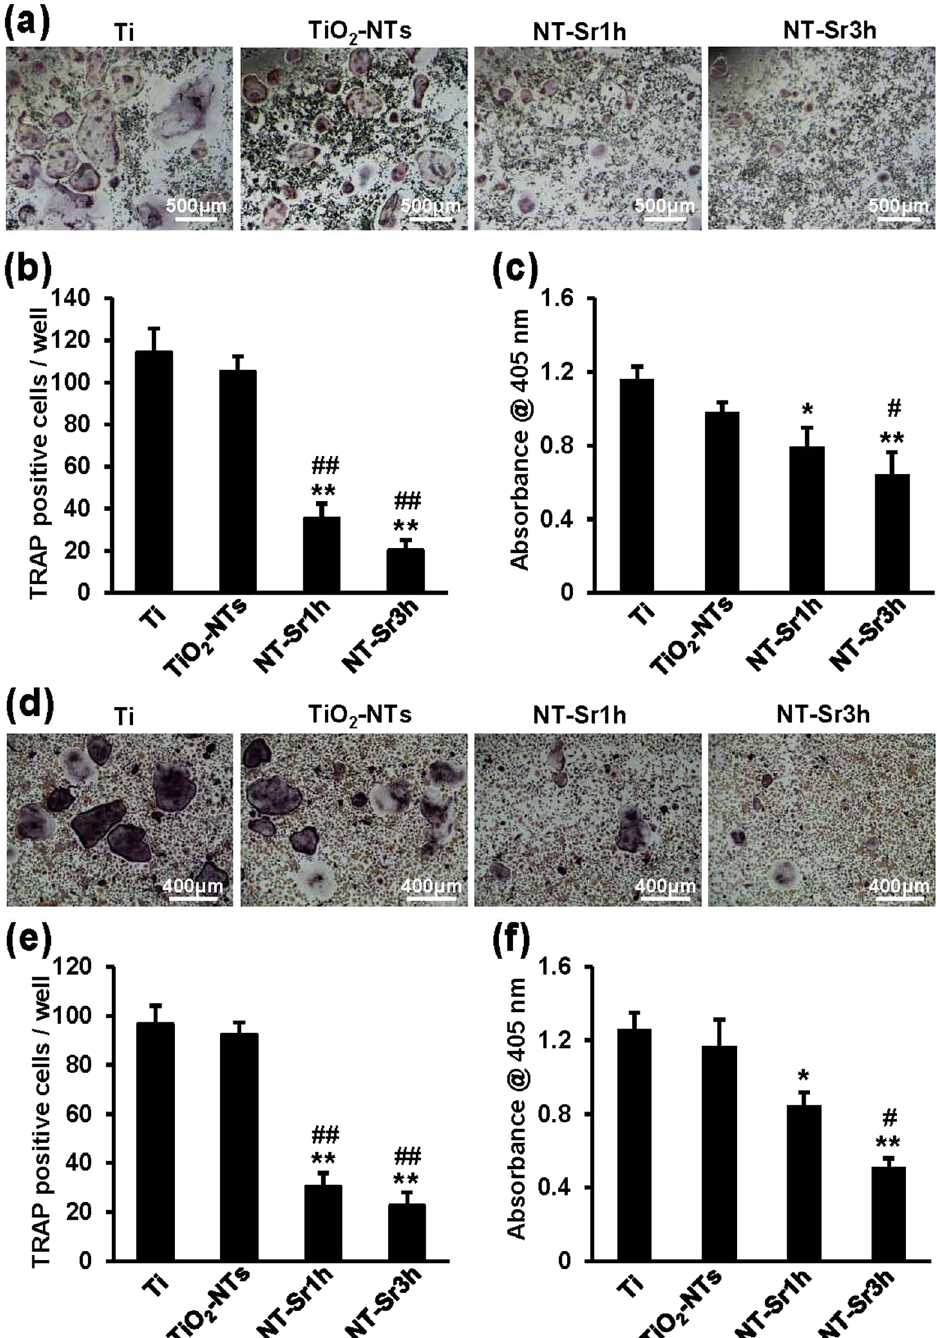
Figure 3. NT-Sr suppress osteoclast formation and activity. ( a , b ) RAW264.7 cells were induced with 50 ng/ mL RANKL on different samples for 5 d and detected by TRAP staining. TRAP-positive cells with at least three nuclei were considered osteoclasts. The number of osteoclasts was quantified. The scale bar represents 500 μ m ( a ). ( c ) RAW264.7 cells were induced with 50 ng/mL RANKL on different samples for 3 d, and TRAP enzyme activity was measured at OD 405 nm. ( d , e ) BMMCs were cultured in the presence of RANKL (50 ng/mL) and M-CSF (30 ng/ml) for 7 d. The cells were then fixed and stained for the TRAP assay. TRAP-positive cells with at least three nuclei were considered osteoclasts. The number of osteoclasts was quantified. The scale bar represents 400 μ m ( d ). ( f ) BMMCs were induced with 50 ng/mL RANKL and M-CSF (30 ng/mL) on different samples for 3 d, and TRAP enzyme activity was measured at OD 405 nm. * , ** p < 0.05 and 0.01, respectively, compared with the Ti group, and #,## p < 0.05 and 0.01, respectively, compared with TiO 2 -NTs. At least three independent experiments were analysed, and the data are presented as the means ±